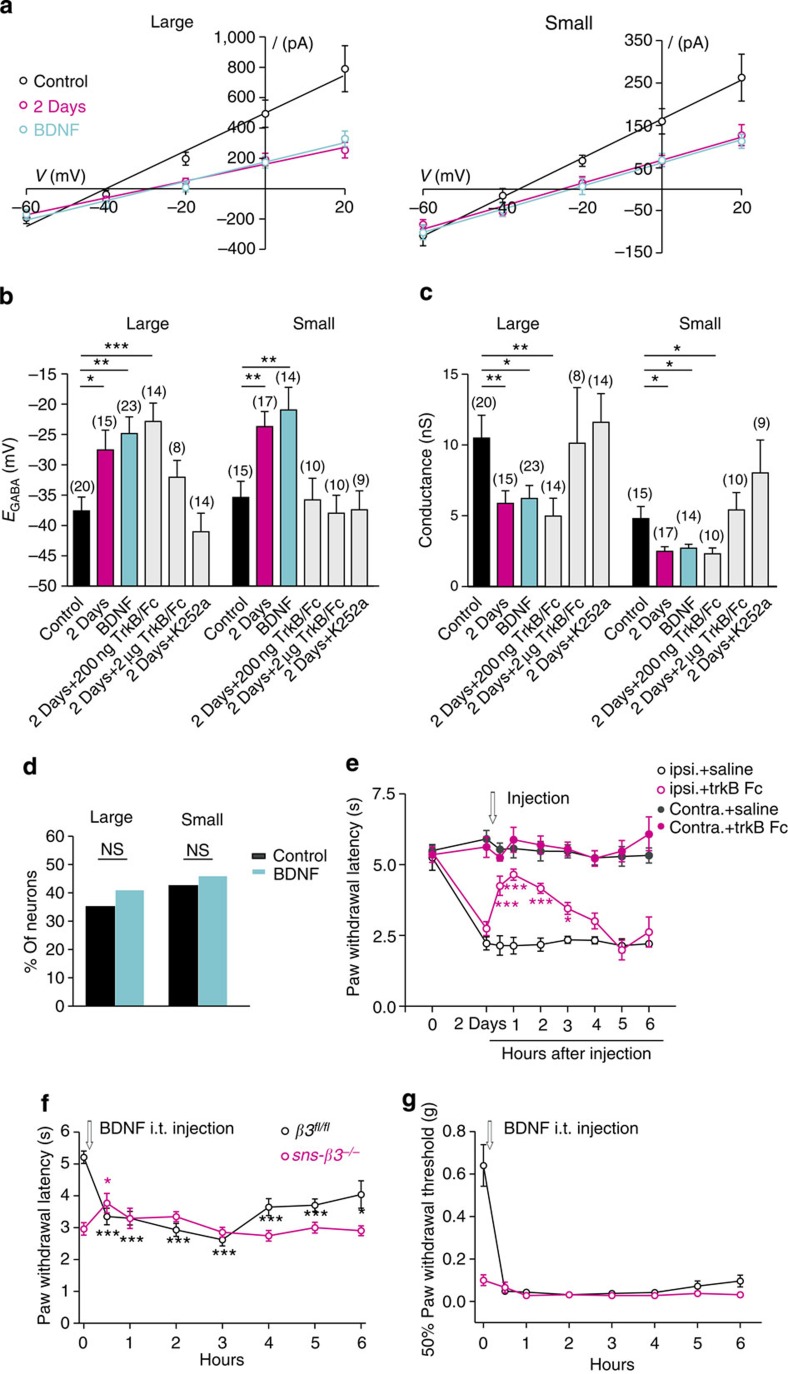
BDNF contributes to neuropathic pain induction through presynaptic GABAAR.(a) Current–voltage relationship for GABA-activated response from large (left) and small (right) neurons. (b) BDNF mimics the effect of nerve injury on EGABA and functional inhibition of BDNF-TrkB signalling reverses the depolarizing shift in EGABA (the number of neurons recorded is indicated in parentheses in each panel; unpaired t-test). (c) BDNF mimics the effect of nerve injury on GGABA and functional inhibition of BDNF-TrkB signalling reverses the reduction in GGABA (unpaired t-test). (d) The proportion of neurons displaying a GABA-evoked increase in [Ca2+]i was not different between control and BDNF-treated DRG neurons (control: large neuron: n=37, small n=207; BDNF: large neuron: n=22, small n=85; Fisher’s test, P>0.05). (e) Intrathecal administration of TrkB-Fc 2 days after nerve injury caused a significant increase in the paw withdrawal latency. n=6 mice/group (TrkB-Fc effect: two-way analysis of variance (ANOVA) with post-hoc Bonferroni test; ipsilateral+saline versus ipsilateral+TrkB-Fc, P<0.0001). Intrathecal injection of BDNF failed to induce heat hyperalgesia (f) in sns- β3−/− mice (n=6 mice per group, BDNF effect: one-way ANOVA with post-hoc Dunnett’s test; β3fl/fl, P<0.01; sns- β3−/−, P>0.05; β3fl/fl versus sns- β3−/−, two-way ANOVA, P<0.001), but did not affect the development of static mechanical allodynia (g) (n=6 mice/group, one-way ANOVA with post-hoc Bonferroni test; β3fl/fl, P<0.0001; sns- β3−/−, P<0.0001; β3fl/fl versus sns- β3−/−, two-way ANOVA, P<0.0001). *P<0.05; **P<0.01; ***P<0.001 versus control (b,c), or versus before injection (e,f). Error bars indicate s.e.m.